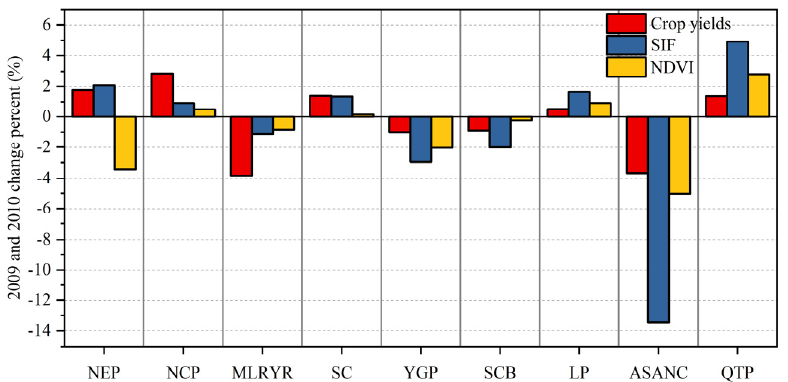
Figure 7. Percentage changes in the per-unit grain yield/SIF/NDVI in the 2009–2010 drought year compared with the corresponding 2001–2019 mean annual values.